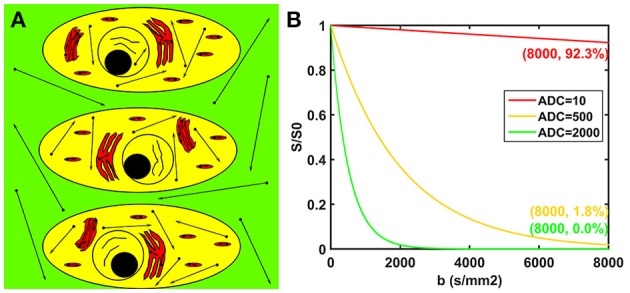
Potential biological interpretations for the three compartments of the modified tri-exponential model (A). The red regions represent the strictly diffusion-limited compartment, the yellow regions represent the slow diffusion compartment, and the green regions represent the fast diffusion compartment. Signal attenuation curves of three ADC values (B). The unit of the ADC values was mm2/s.